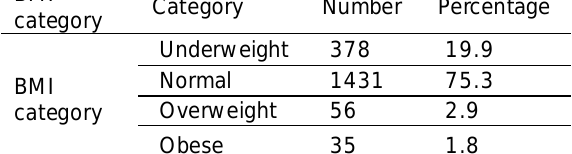
Table 2: BMI classification of the